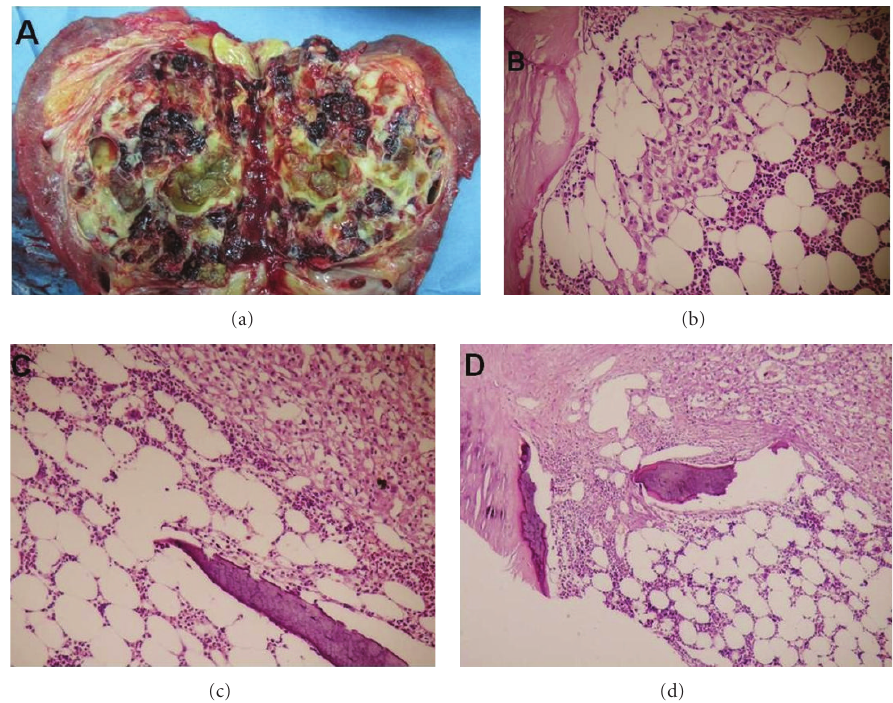
Figure 2: (a) Longitudinal section of specimen shows cystic lesions throughout the kidney. (b) Metaplastic bone intermingled with fat tissue containing myeloid and erythroid cells and varying numbers of foamy histiocytes (H&E x40). (c), (d) Lamellar bone forming a trabecula, adipose tissue, hemopoietic cells, and renal cell carcinoma (H&E